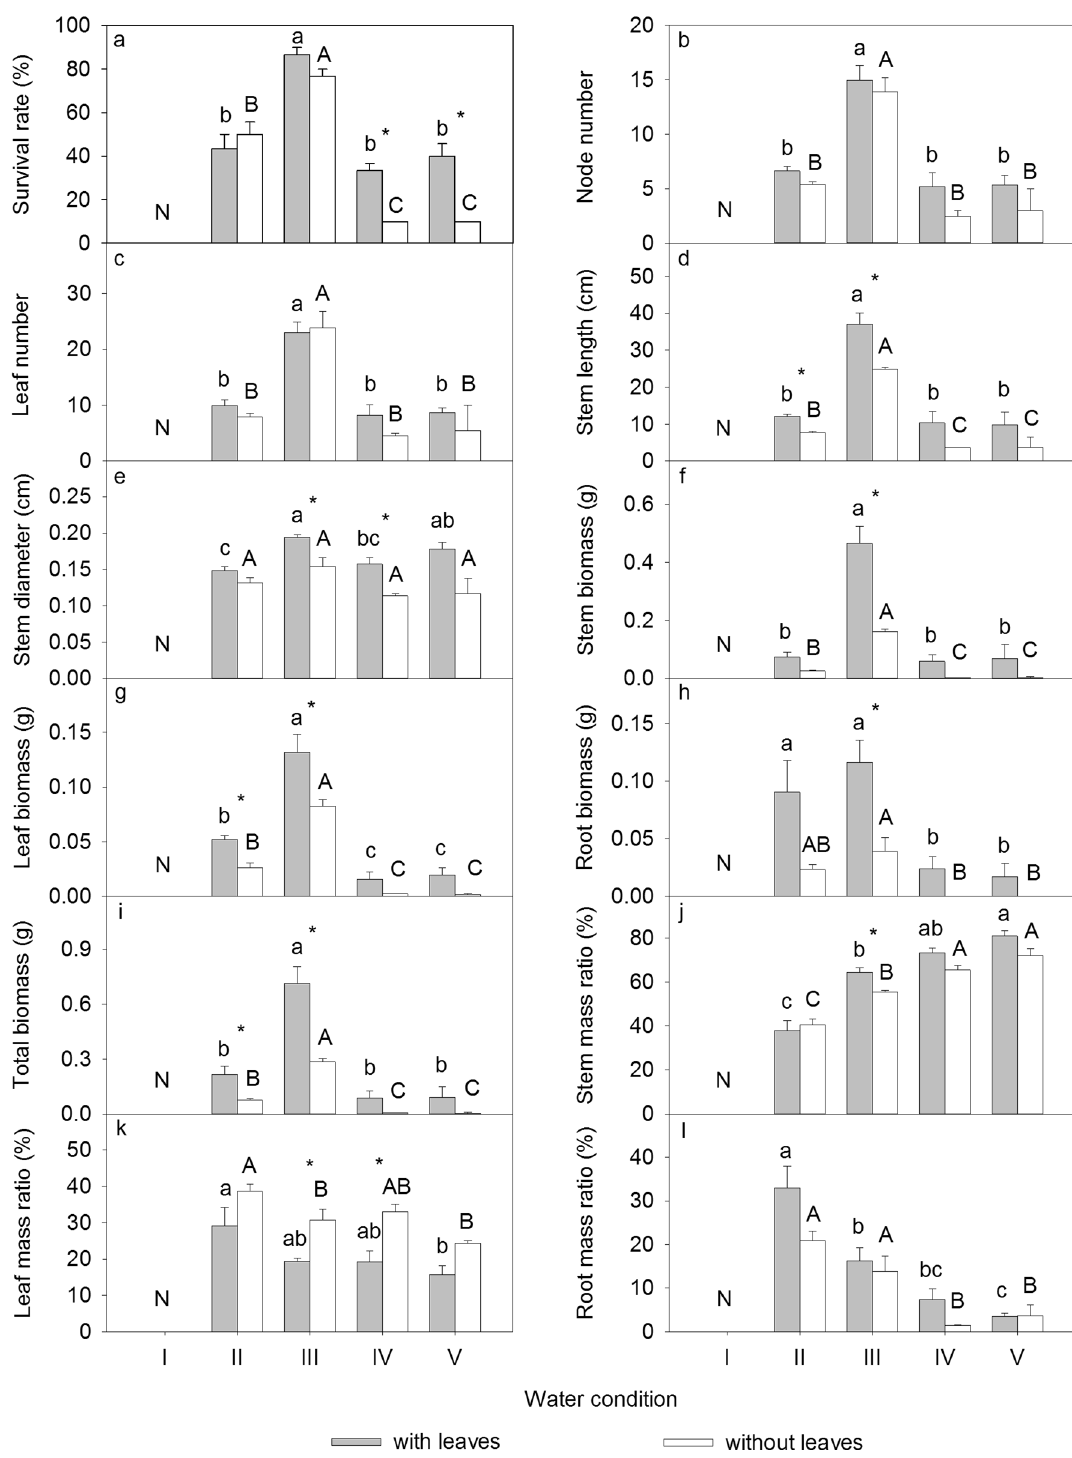
Figure 1. Survival rate, morphological traits, biomass, and biomass allocation of A. philoxeroides in Exp. 1. Means + SE are given. I, 30% soil water content; II, 70% soil water content; III, 97% soil water content; IV, water depth of 5 cm; V, water depth of 10 cm. Different uppercase and lowercase letters indicate significant differences among different water conditions. *indicates significant differences between different leaf treatments. An uppercase N indicates no